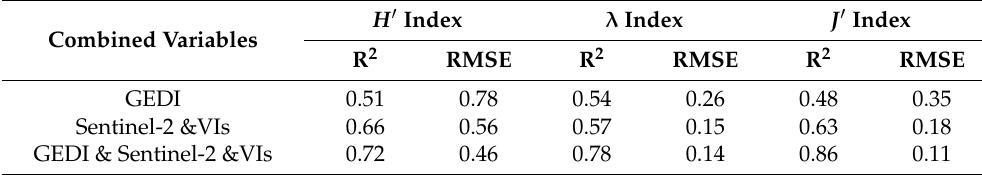
Table 5. Estimated accuracy for different data combinations in three diversity indices.